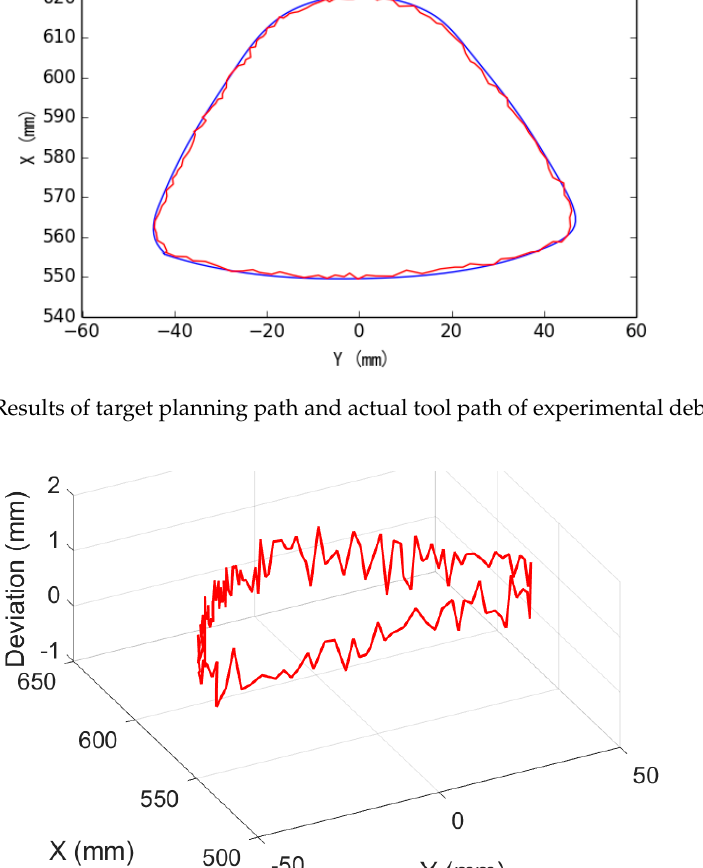
Figure 19. Deviation results of target planning path and actual tool path of experimental deburring